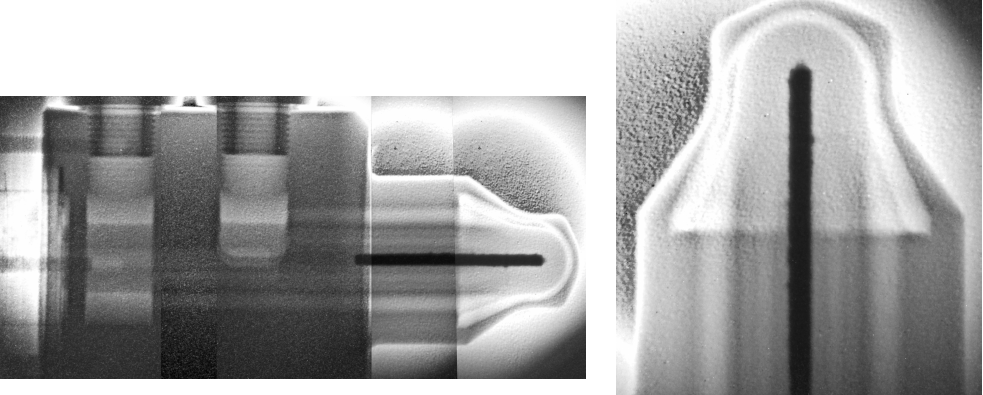
Figure 10. Radiograph of an irradiated AD-Target assembly. From the zoom in the right panel, the non-uniformity of the inner core (which should present itself as a perfect straight line, as in Figure 9) is clearly visible highlighting internal damage.